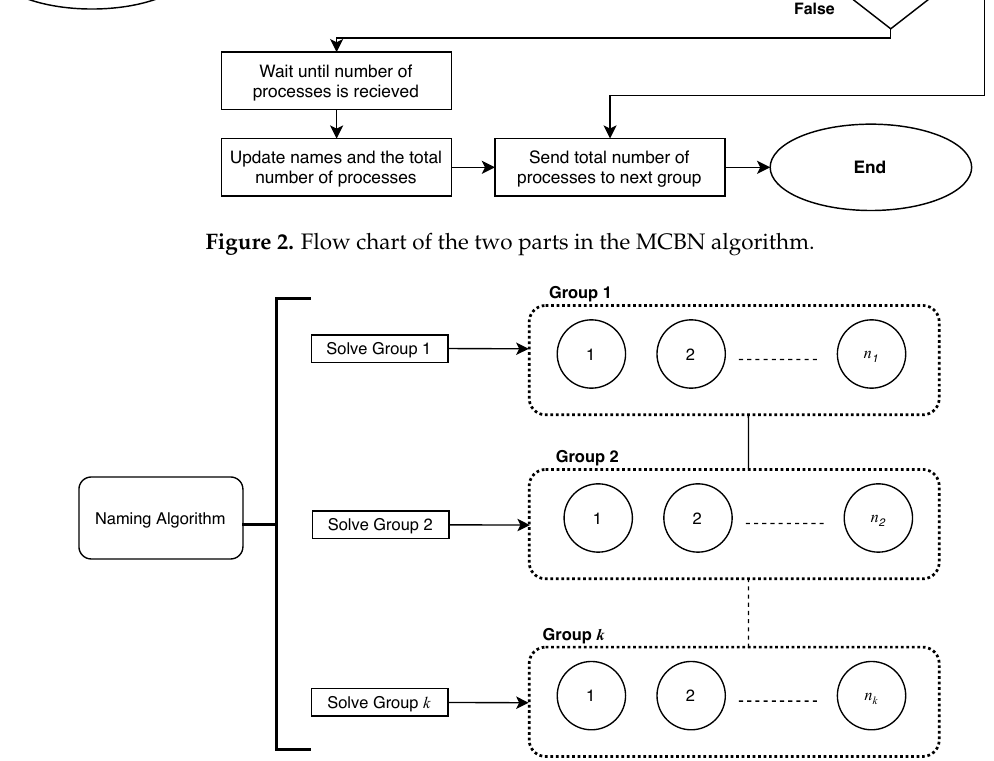
Figure 3. How names are assigned in the first part of the MCBN and the UMCBN